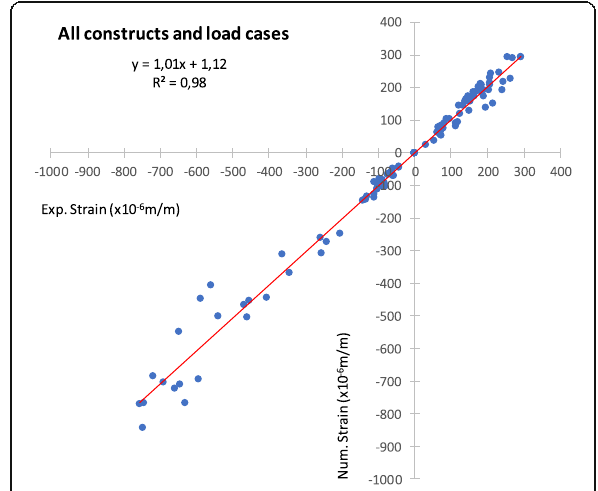
Fig. 3 Linear regression between experimental and numerical cortical strains (all strain gauges, all construct techniques and load